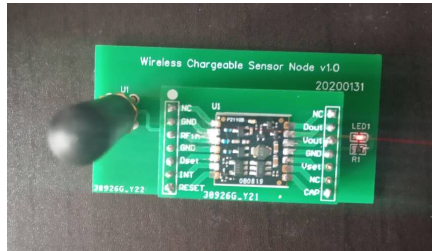
Figure 4. Pratical experimental sensor node.